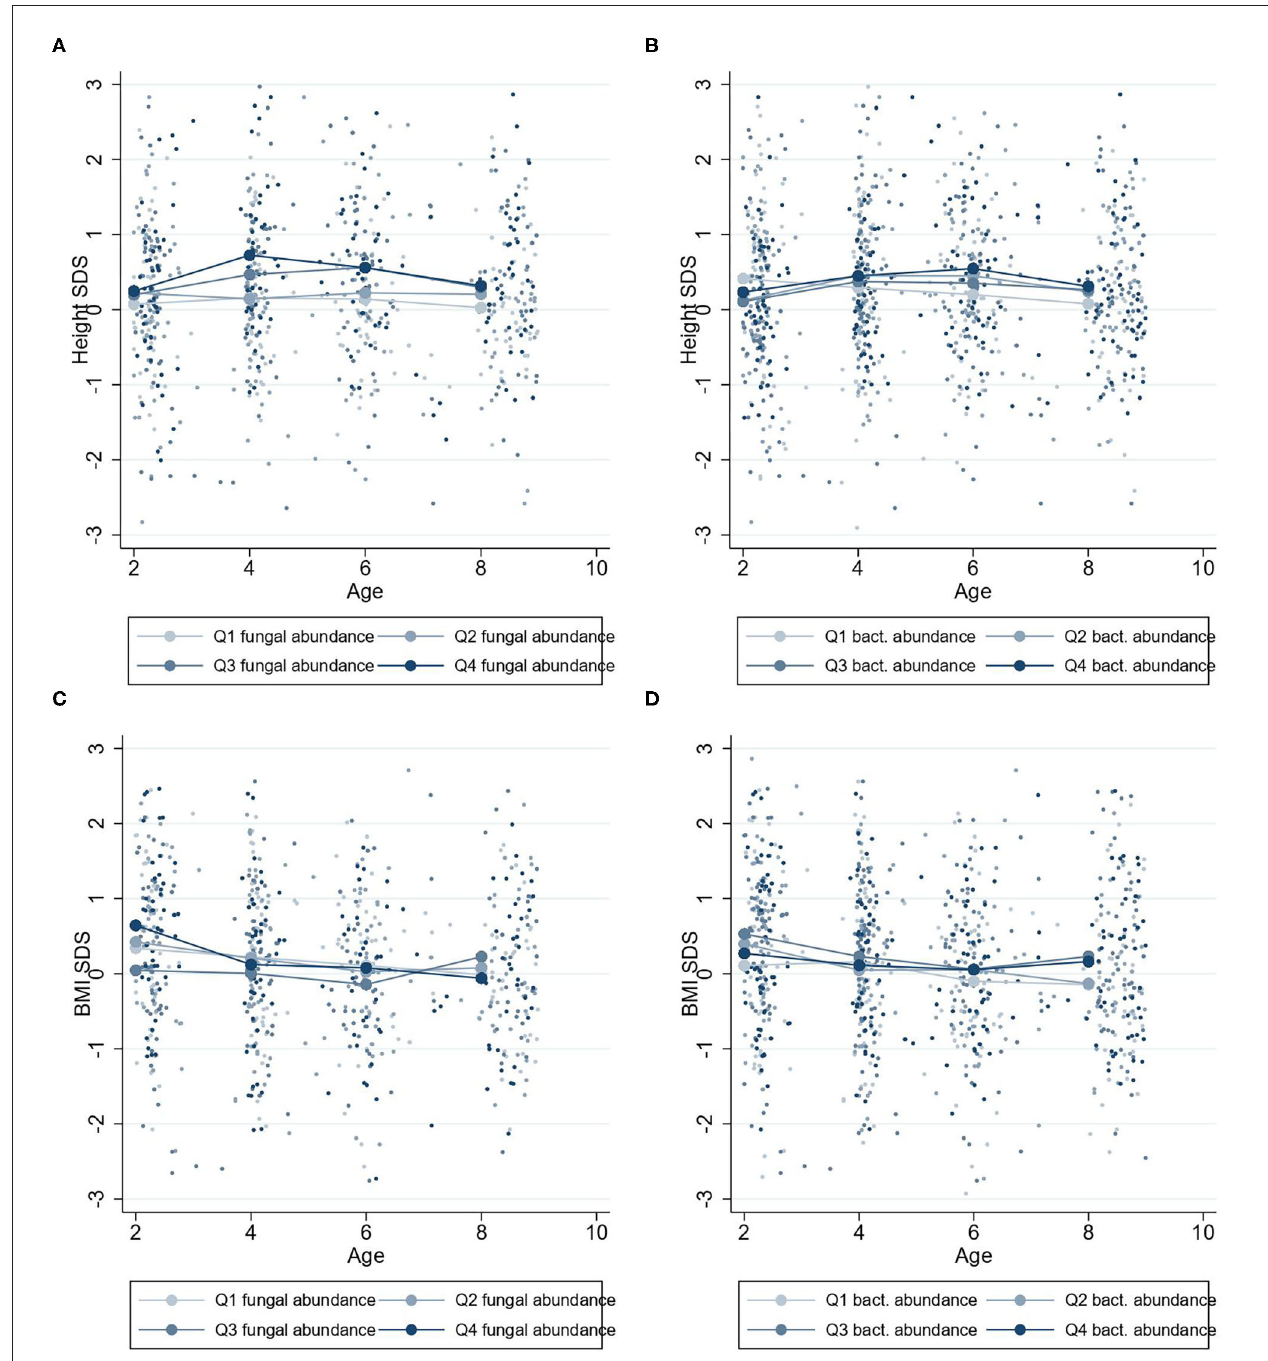
FIGURE 5 | Mean height-SDS and BMI-SDS at 2–9 years according to microbiota abundances at 2 years. Mean standard curve deviation (SDS) values for children at 2–9 years with four quartiles of microbiota abundances at 2 years. Group mean height-SDS at 2–9 years for four quartiles of abundances of fungi (A) and bacteria (B) . Group mean BMI-SDS at 2–9 years for high or low abundances of fungi (C) and bacteria (D) .